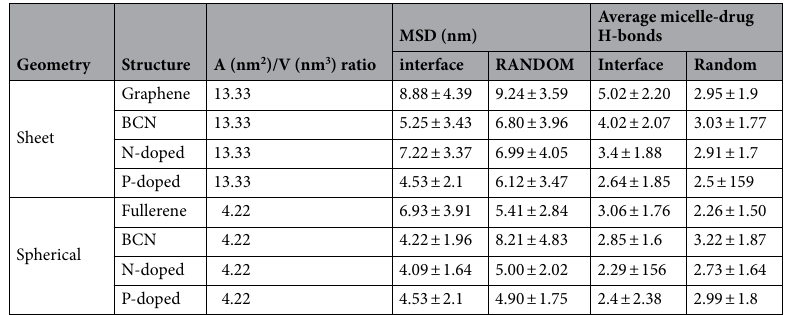
Table 2. Properties of nanocarbon and the average H-bonds between the drug and micelles for each